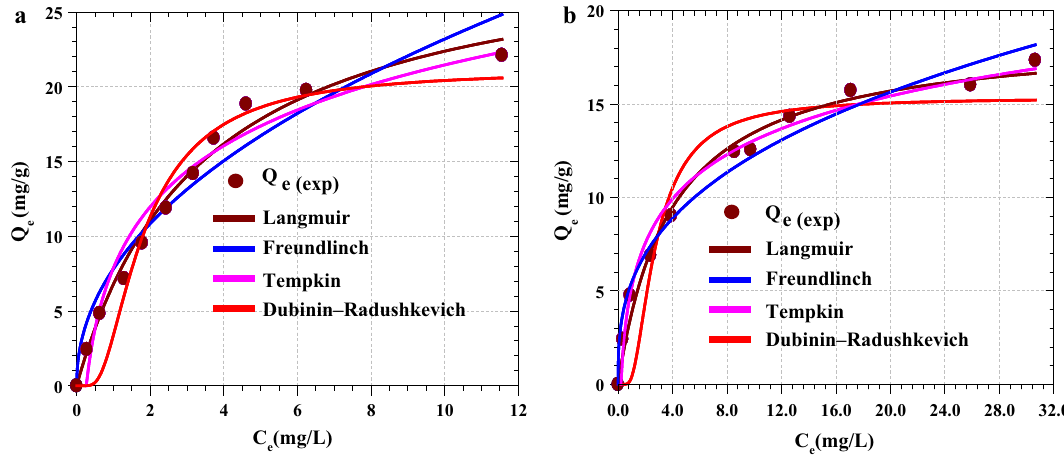
Fig. 11 Adsorption isotherms fits of MB and CV onto